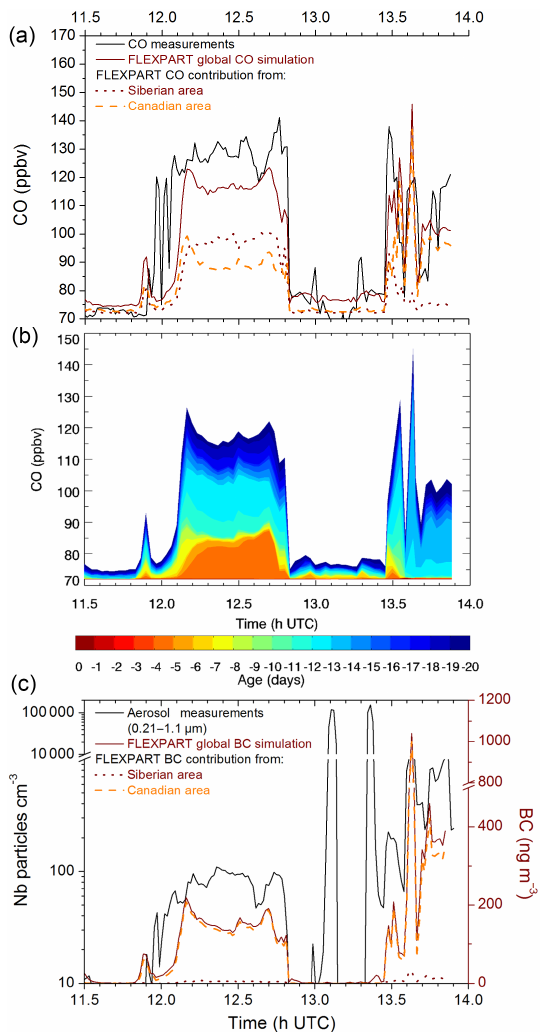
Figure 6. Zoom on a part of F2 from 11:30 to 14:00UTC above Sar- dinia at 5.4km with an injection height up to 10km in FLEXPART. (a) CO time evolution along the flight: SPIRIT vmr (degraded to FLEXPART time resolution) and FLEXPART simulations. (b) CO vmr calculated by FLEXPART, colour-coded according to the age, from 1 to 20 days before F2, of the air mass. (c) BC time evolution along the flight: PCASP measurements (degraded to FLEXPART time resolution) and FLEXPART